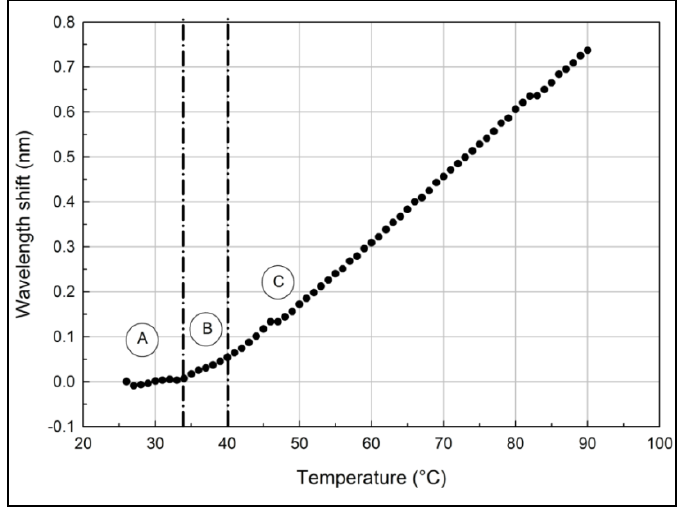
Figure 3. Wavelength shift versus